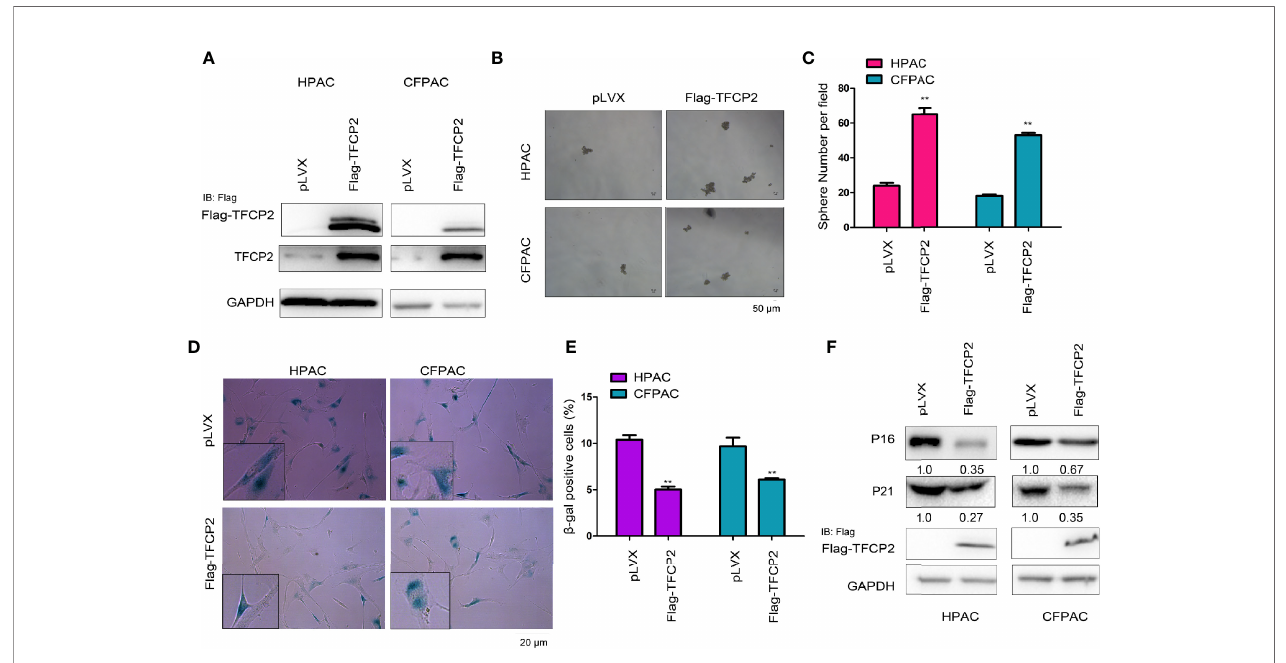
FIGURE 2 | TFCP2 inhibited the senescence of pancreatic cancer cells. (A) The pancreatic cells were infected with the lentivirus for the overexpression of TFCP2. Cells were selected with puromycin and the resistant cells were pooled. The expression of exogenous and total TFCP2 was examined using western blot. (B, C) Sphere formation assay was performed to evaluate the effects of TFCP2 overexpression on the cell growth. (D, E) b -Gal staining was performed to evaluate the effects of TFCP 2 overexpression on the cell senescence. (F) The protein levels of senescence modulators were examined using western blot. The fold change was indicated. ** P <